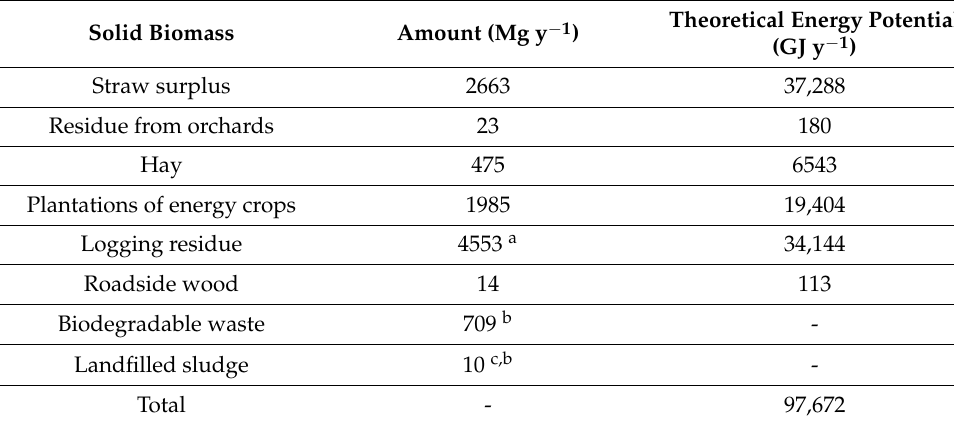
Table 4. The amount and energy potential of each solid biomass type.